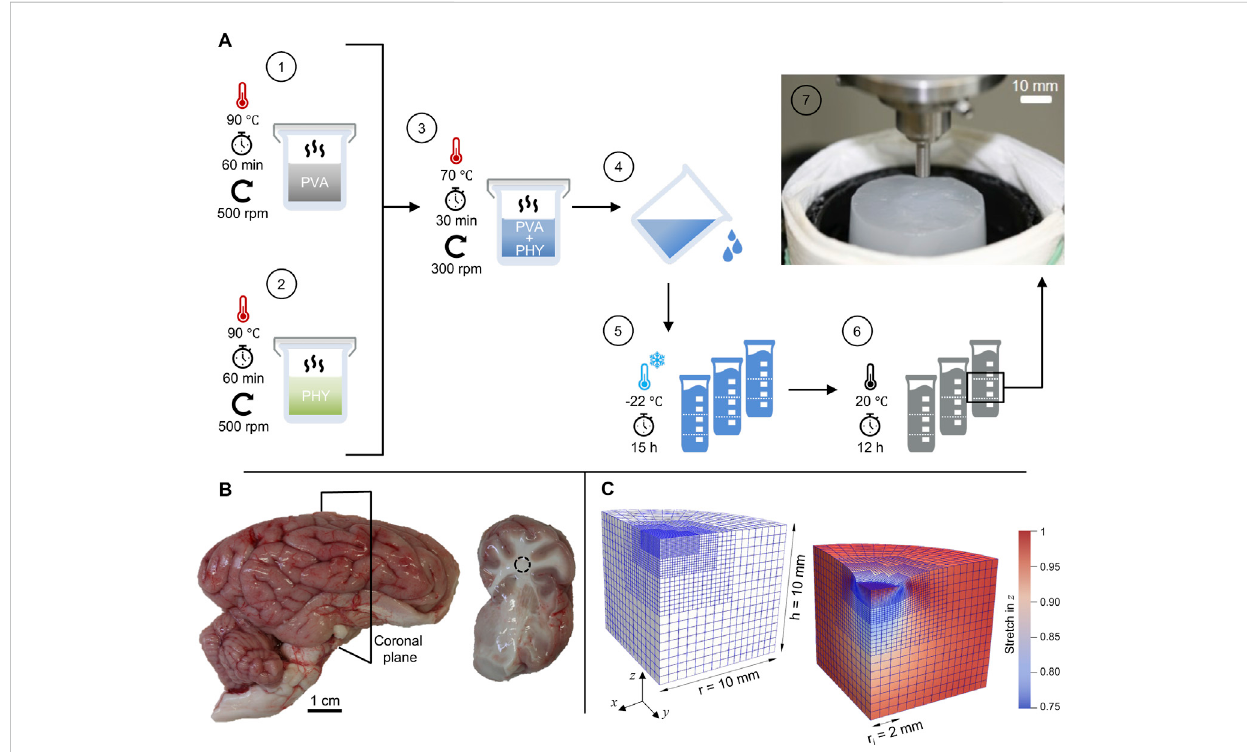
FIGURE 1 Preparation methods and materials: (A) Schematic representation of the standardized preparation procedure for hydrogel synthesis with polyvinyl alcohol (PVA) and Phytagel (PHY). The inset in step 7 shows a hydrogel sample on the sample stage during an indentation test. (B) Porcine brain hemisphere with cerebrum, cerebellum and brain stem. The slices (right image) were obtained by cutting along the coronal plane. (C) Finite element model in undeformed (left) and deformed con fi guration (right) for simulating the fl at-punch indentation experiment with the poro-viscoelastic